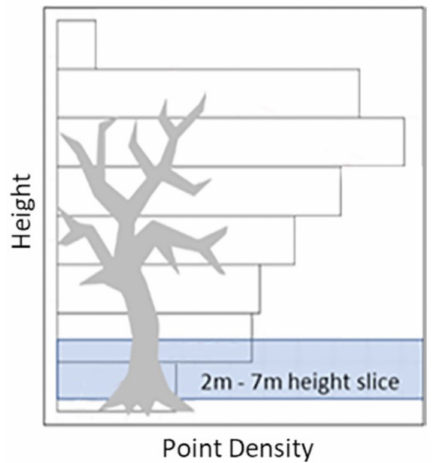
Figure 7. Conceptual illustration of use of point density distribution to determine a target height range in the point cloud that excludes tree crowns and ground foliage so that tree stems can be more readily